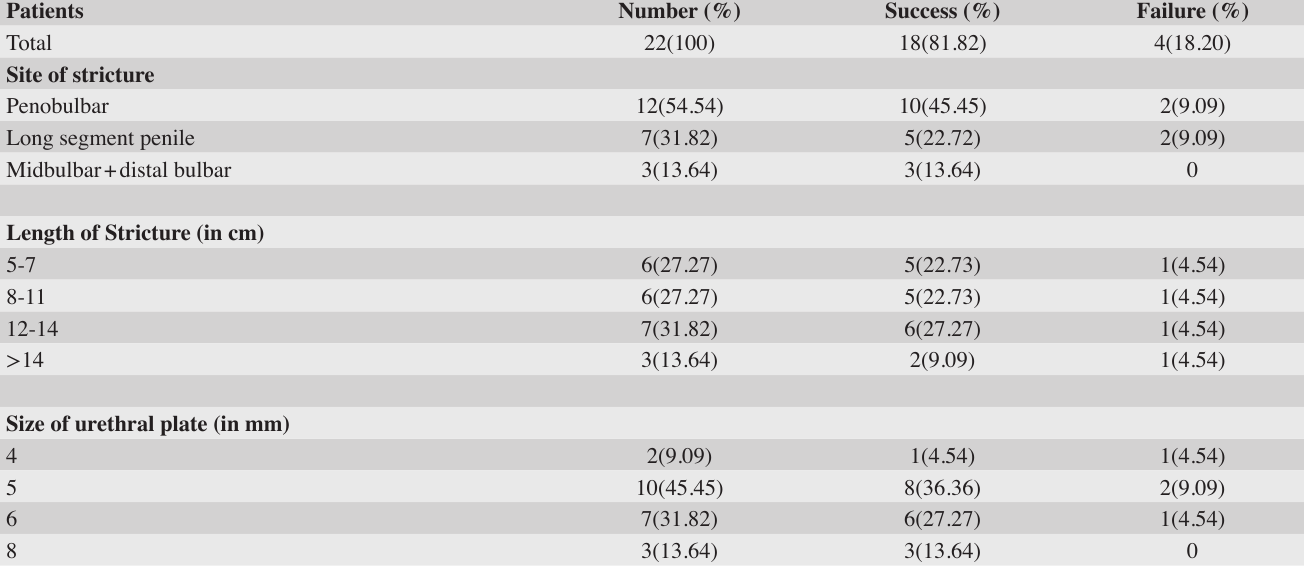
Table 1. Success and Failure Rate According to Stricture Site, Stricture Length, and Urethral Plate Size